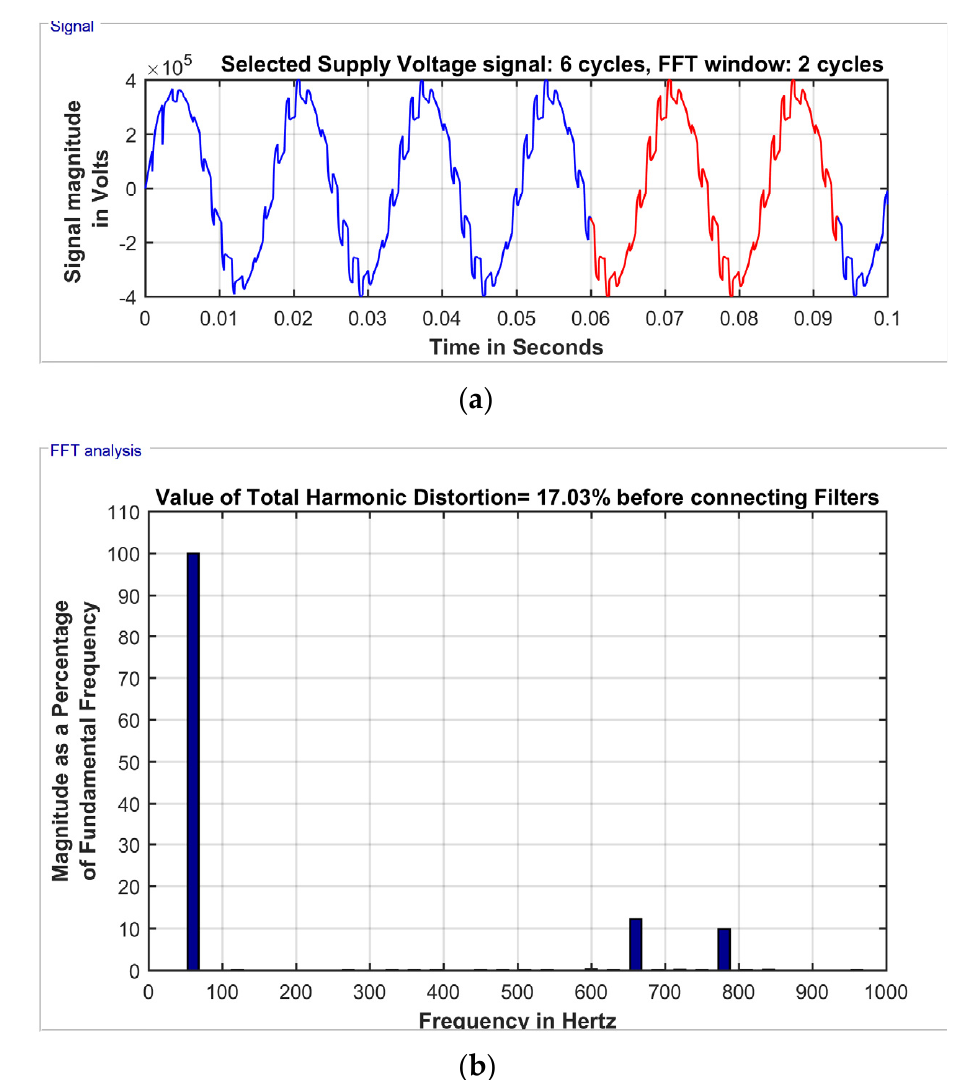
Figure 13. Before connecting harmonic filters: ( a ) supply voltage and ( b ) plot of FFT analysis.